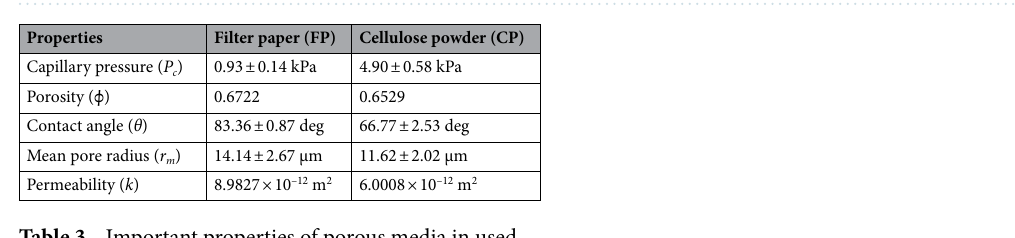
Figure 2. Analysis of alcohol dripping. ( A) The relations from porous medium types to droplet breakup. Please refer Table 2 for the definitions of parameters and acronyms. ( B ) Average flow rates of water and alcohol ( n = 5). ( C ) T drop vs. N drop during the pump operation where D O denotes the nozzle diameter in millimeter ( n = 15). Theoretical T drop values incorporating the Harkins-Brown (H-B) correction factors are depicted by hollow circles. ( D – G ) The elapsed time of alcohol droplet breakup ( D : D O = 1.0, E : D O = 1.5, F : D O = 2.2, G : D O = 3.2 mm); dashed lines represent linear regression data ( n = 15). Note that all the error bars denote standard deviations.